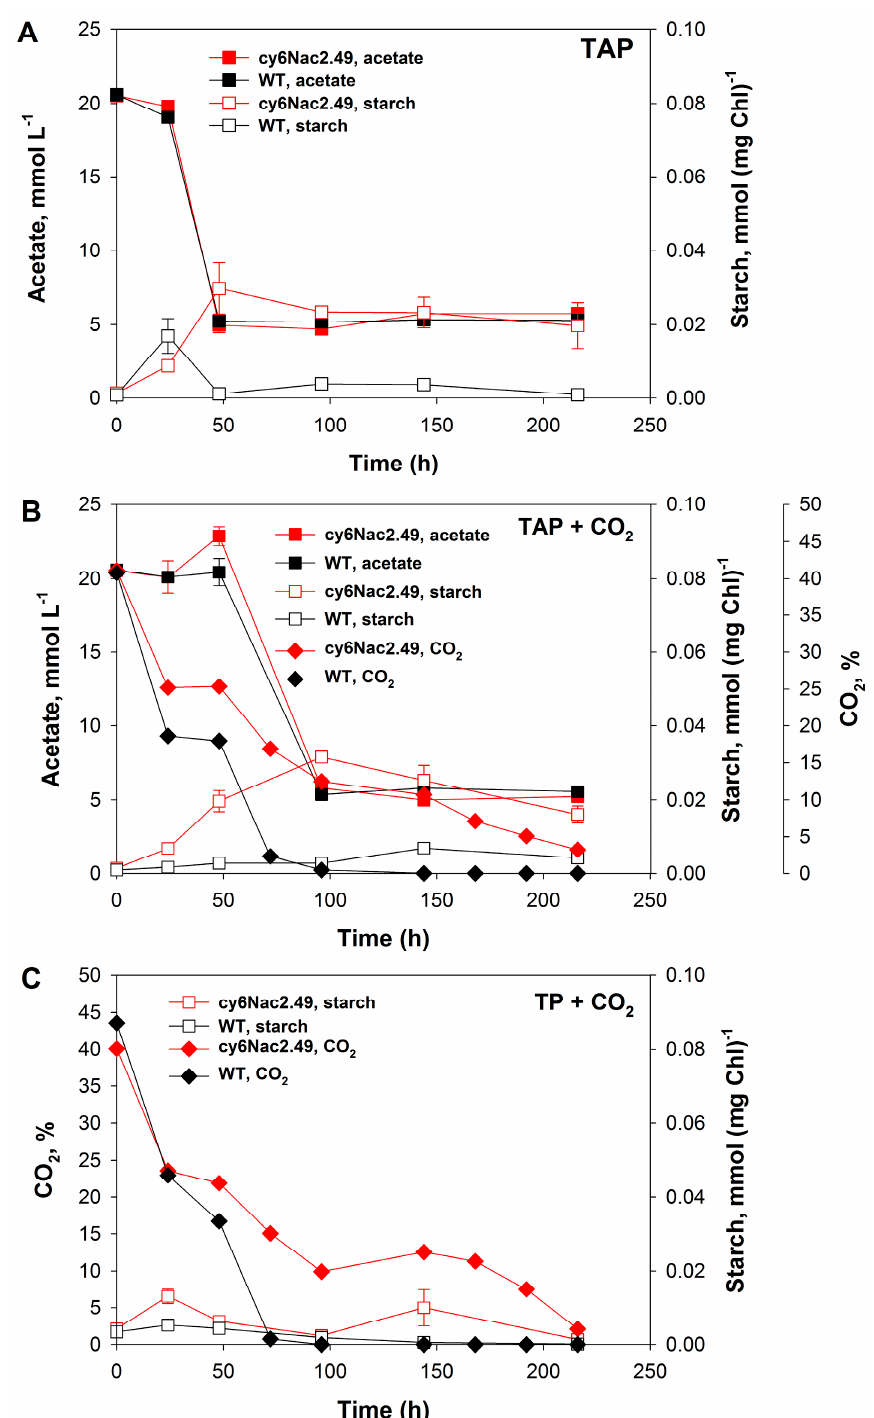
Figure 2. Changes in the amount of starch accumulated, the acetate content of the medium and amount of CO 2 in the gas phase during the incubation of C. reinhardtii strain cy6Nac2.49 (red) and it is parental wild-type (black) under ( A ) photoheterotrophic (TAP); ( B ) photomixotrophic (TAP + CO 2 ); and ( C ) autotrophic (TP + CO 2 ) growth conditions under continuous illumination (10 W·m − 2 ).